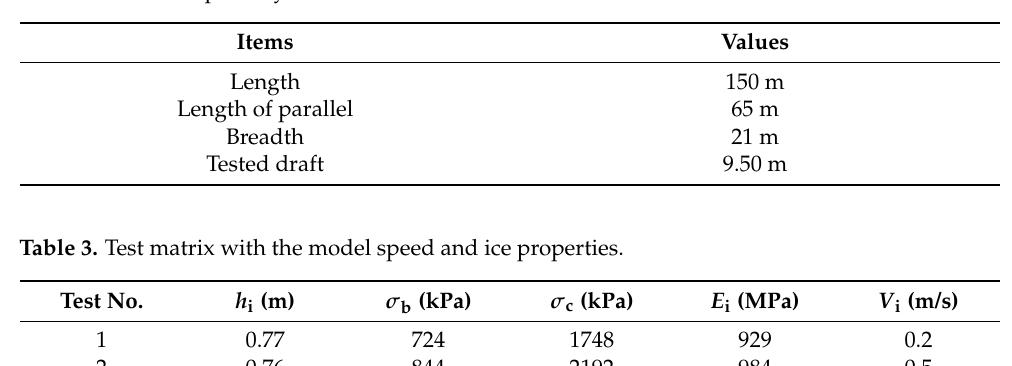
Table 2. Full-scale primary dimensions of MT Uikku.